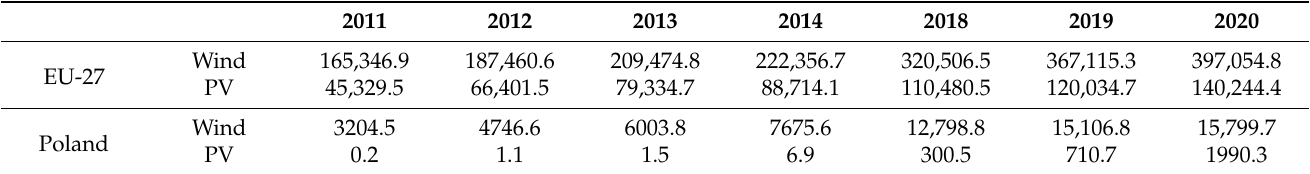
Table 1. Wind and photovoltaic energy production (GWh) Reprinted with permission from ref. [1]. 2021